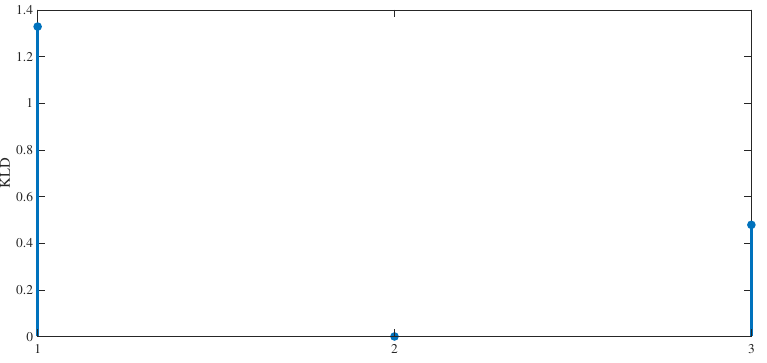
Figure 21. Deep PCA-based and KLD-based fault isolation for f 1 with FNR enhancement.